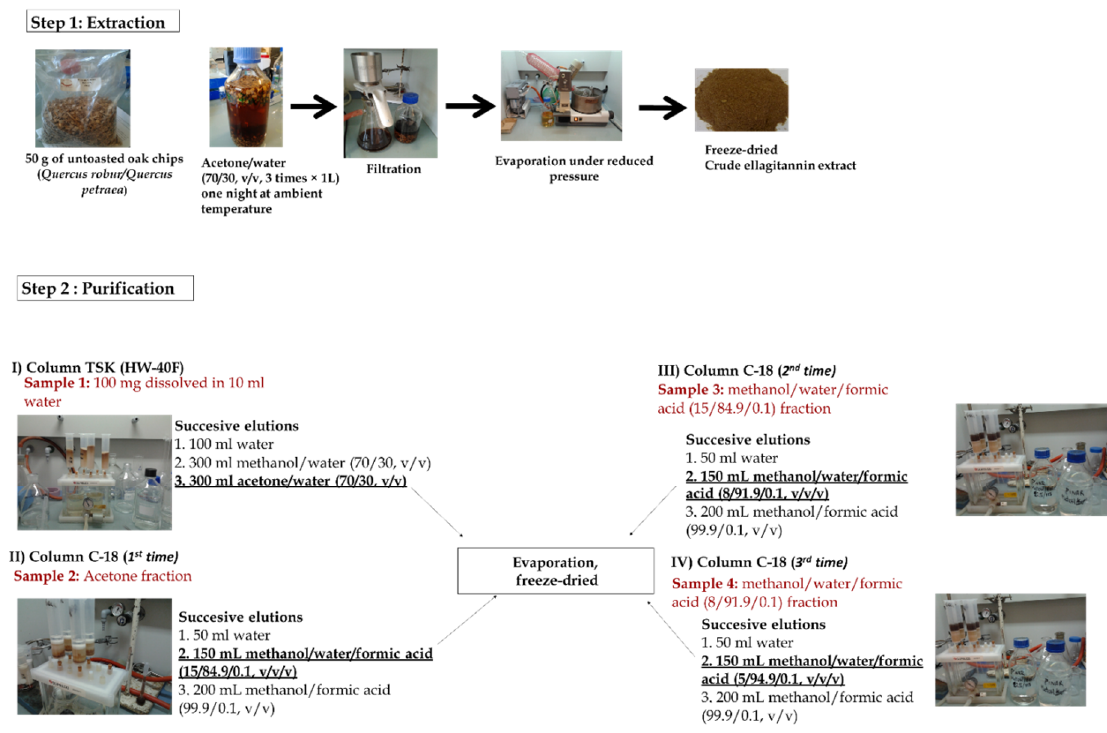
Figure A1. Ellagitanins extraction and pre-purification.